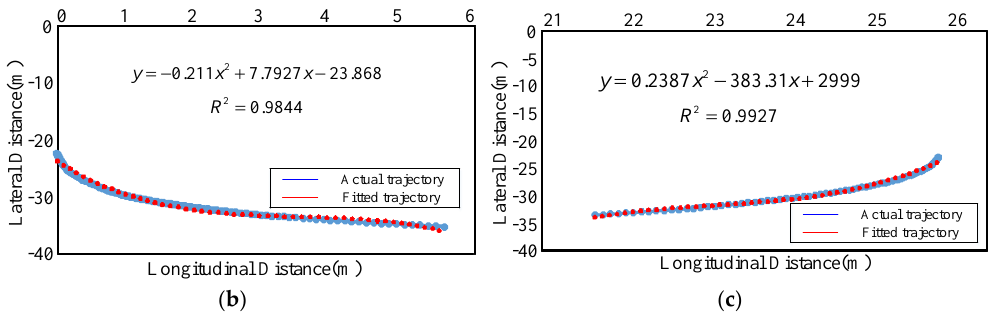
Figure 2. Trajectory fitting under U-turn: ( a ) Full trajectory; ( b ) The first paragraph trajectory; ( c ) The second paragraph trajectory.